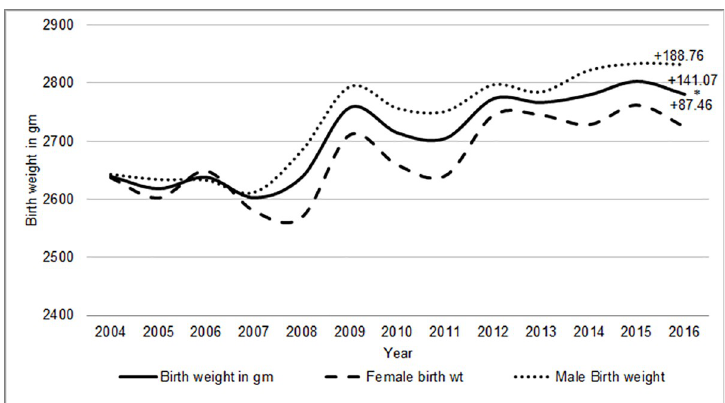
Fig 1. Distribution of mean birth weights from the year 2004 to 2016. � p for trend using regression < 0.001.